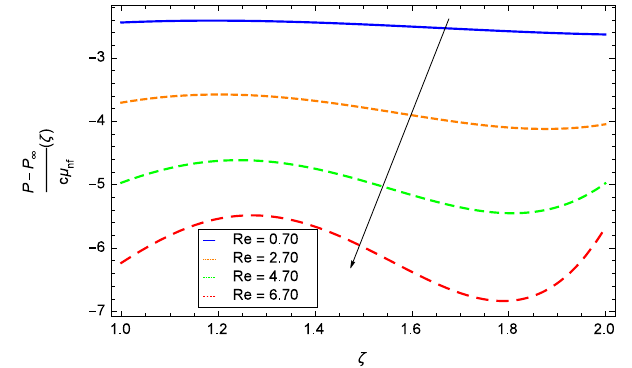
Figure 15. Non-dimensional Pressure P − P ∞ Pr = 6.80 and greater quantities of Re (CuO-H 2